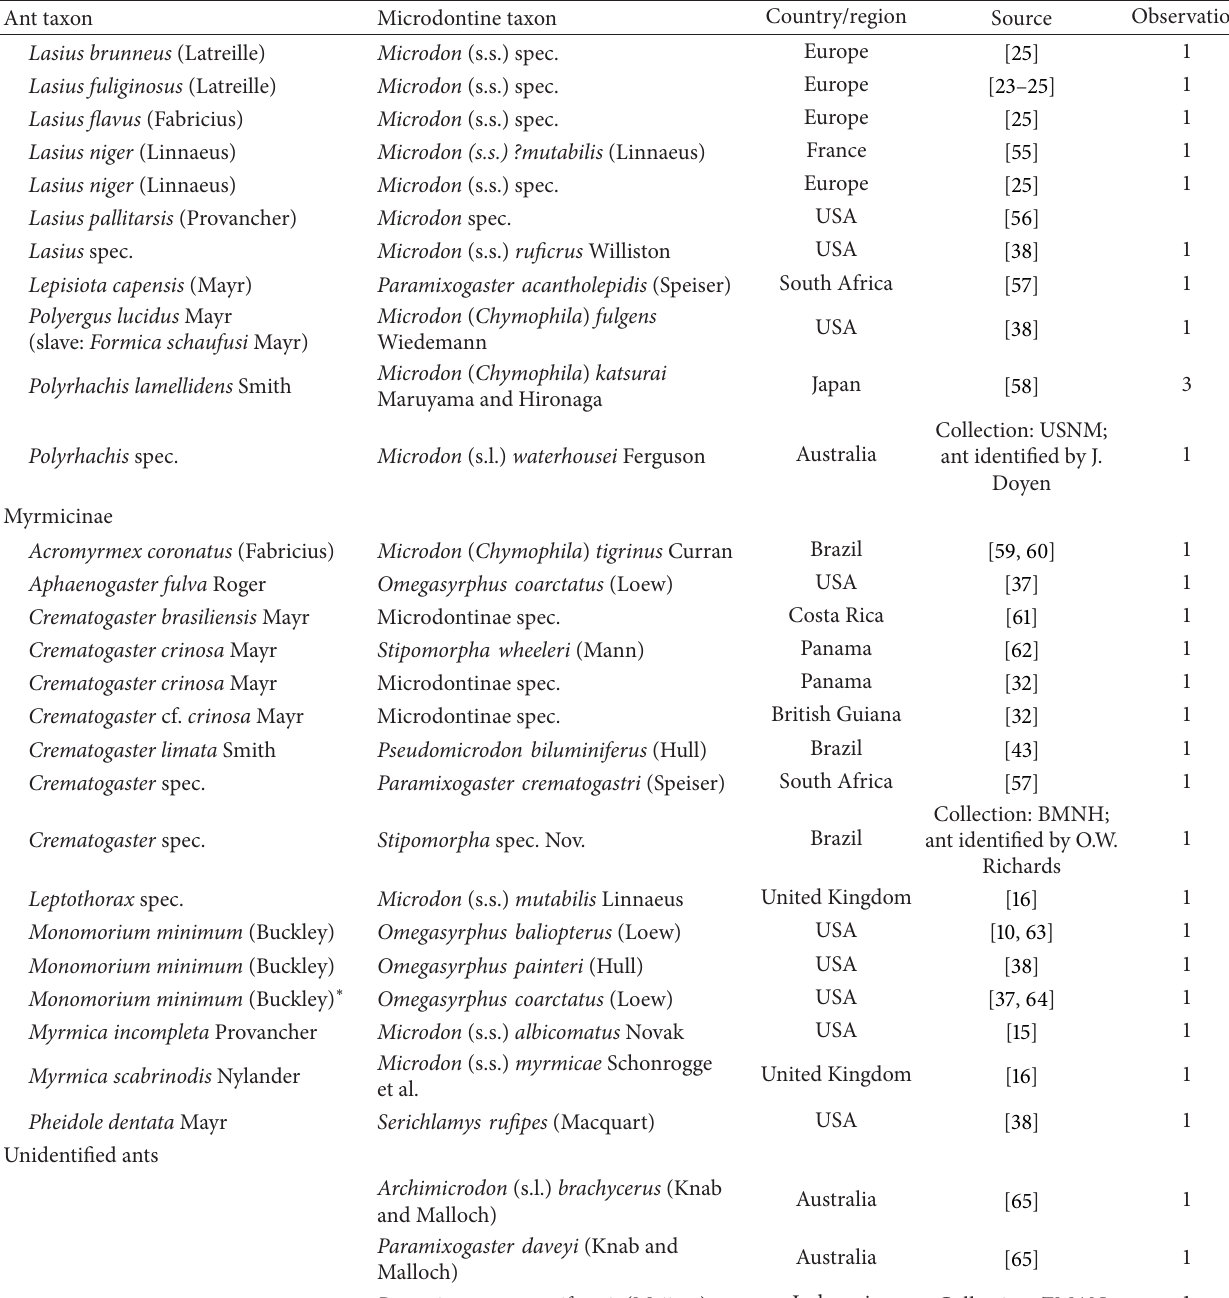
(Figure 1). Spheginobaccha de Meijere (tribe Spheginobac- chini) is the sister group to all other Microdontinae (tribe Microdontini), but the larvae of this taxon are presently unknown. Within the tribe Microdontini (the remaining part of the tree), Mixogaster Macquart is the first genus to branch off (a strongly supported clade; see Reemer and St ˚ ahls